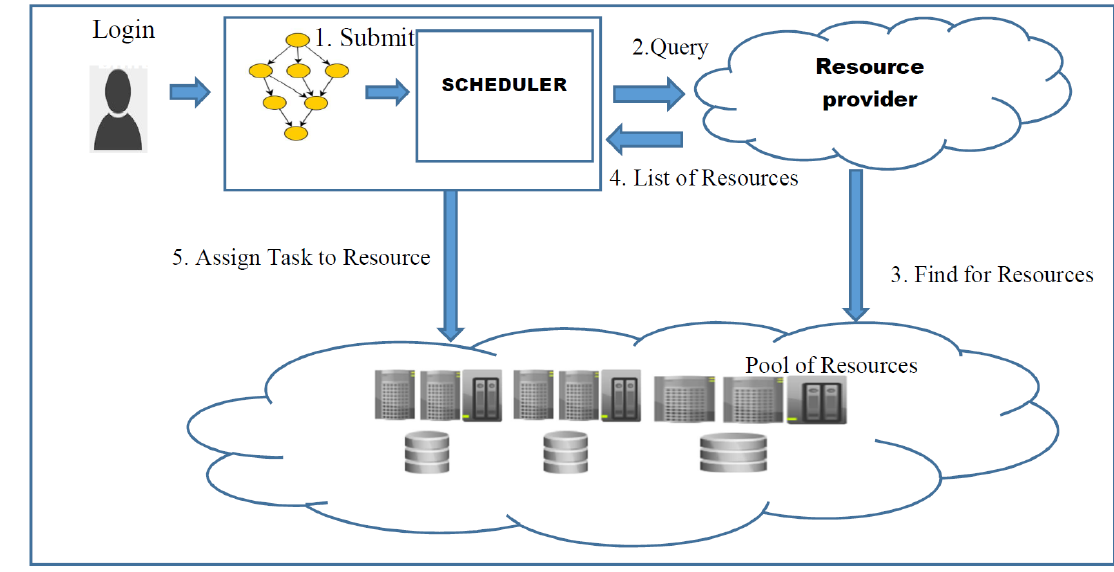
Figure 1. Workflow scheduling model.